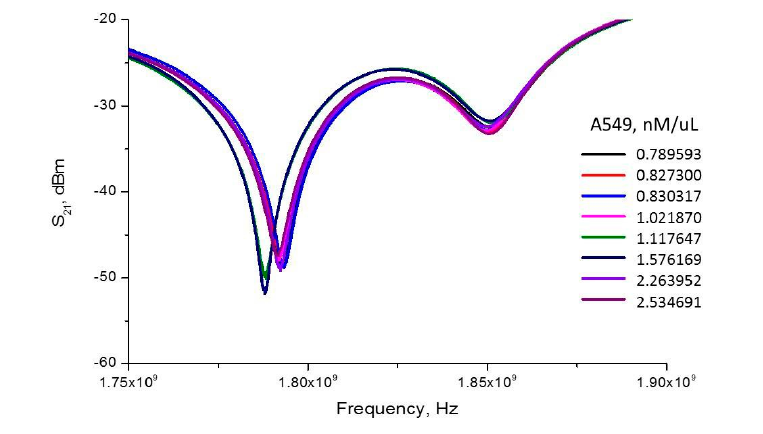
Figure 5. S 21 measurements for A549 cells samples with known lactate level in 1.75 GHz–1.9 GHz